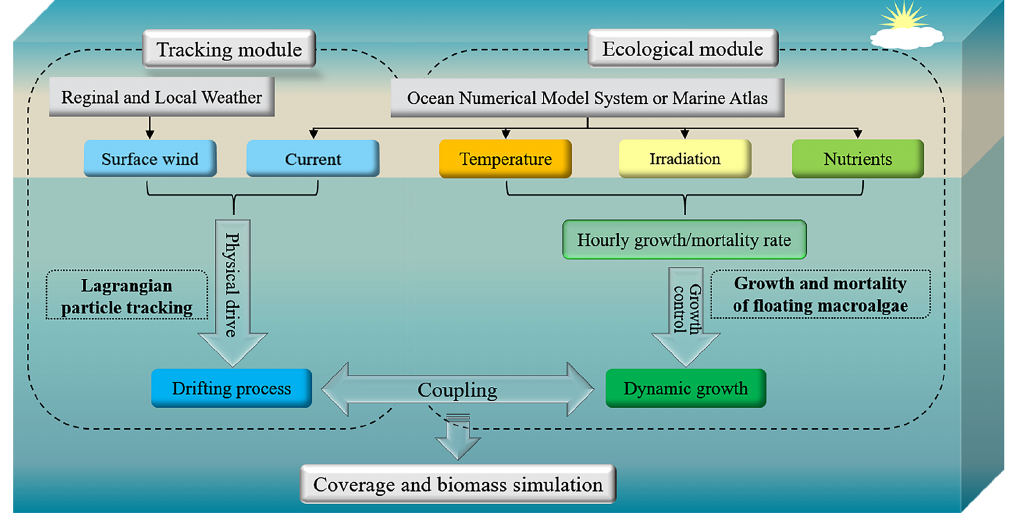
Figure 1. The framework of the physical–ecological coupled model FMGDM v1.0.